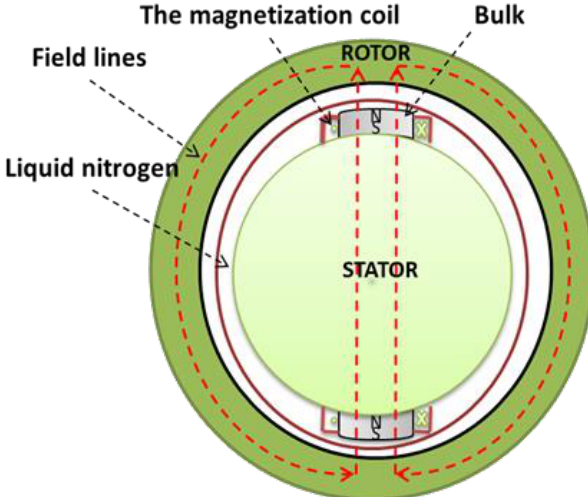
Figure 7. Simplified magnetic circuit of HTS bulk motor.